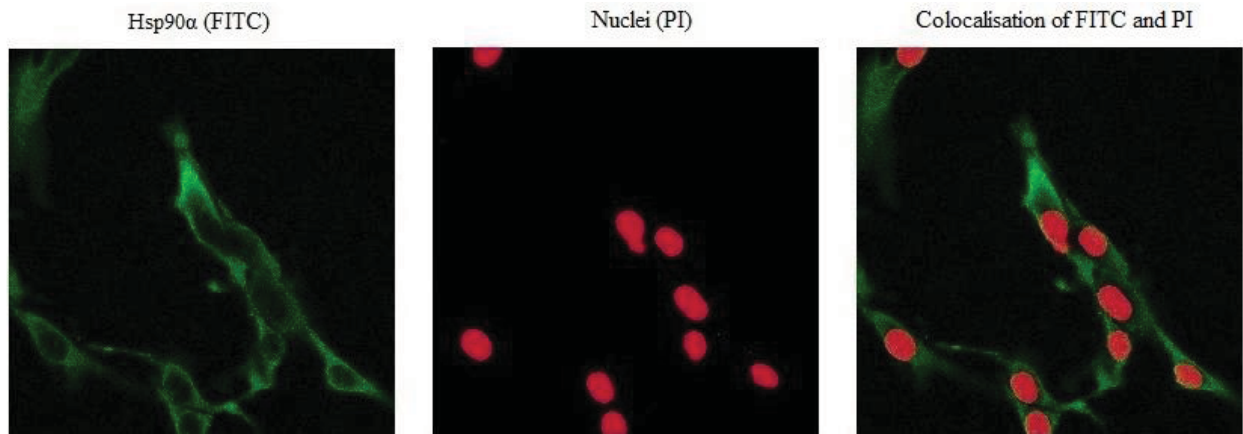
Figure 4. Hsp90 (cid:2) protein level in U87-MG assessed using immunohistochemistry. The cells were stained with FITC conjugate secondary antibody bound to Hsp90 (cid:2) antigen (green) and propidium iodide (PI) to detect nucleus (red) at ×40 objective magnifications. Hsp90 (cid:2) was mainly located in the cell cytoplasm.